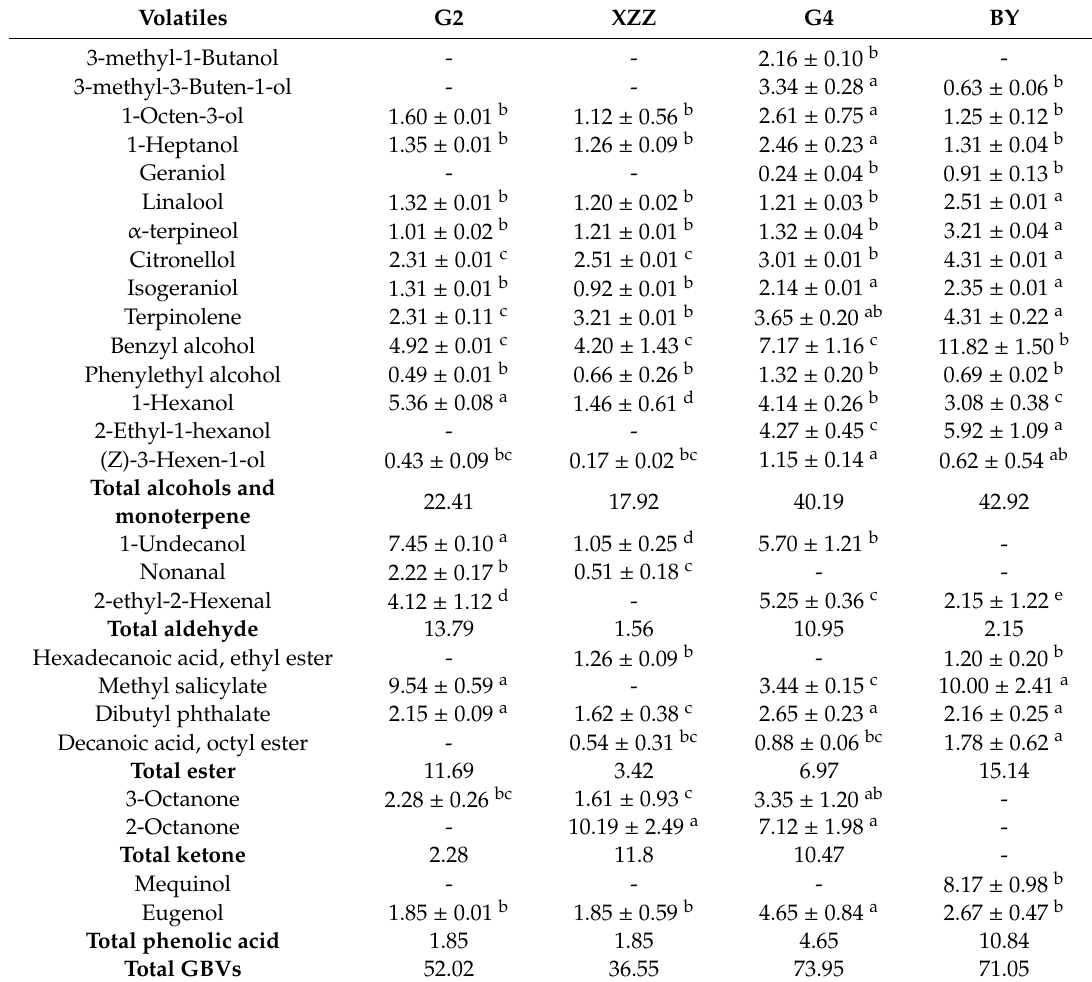
Table 3. Glycosidically bound volatiles of Chinese wild spine grapes ( µ g /